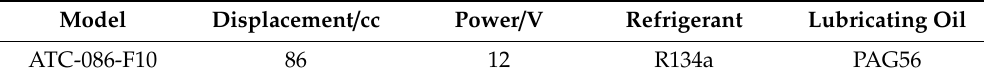
Table 1. The basic parameters of the compressors.